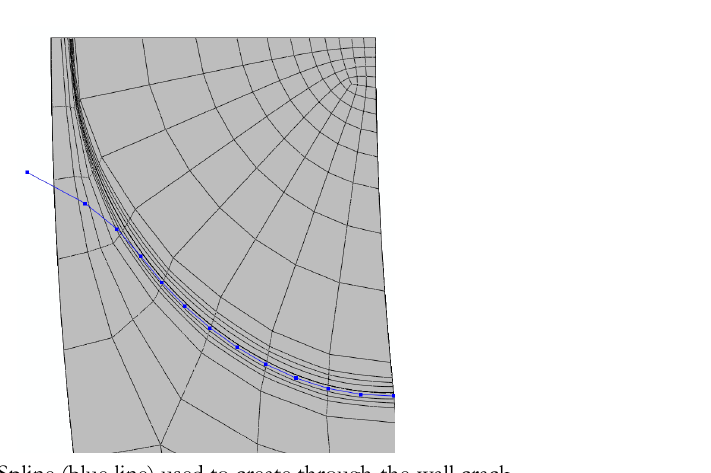
Figure 17: K vs . a for thickness node (conductor).